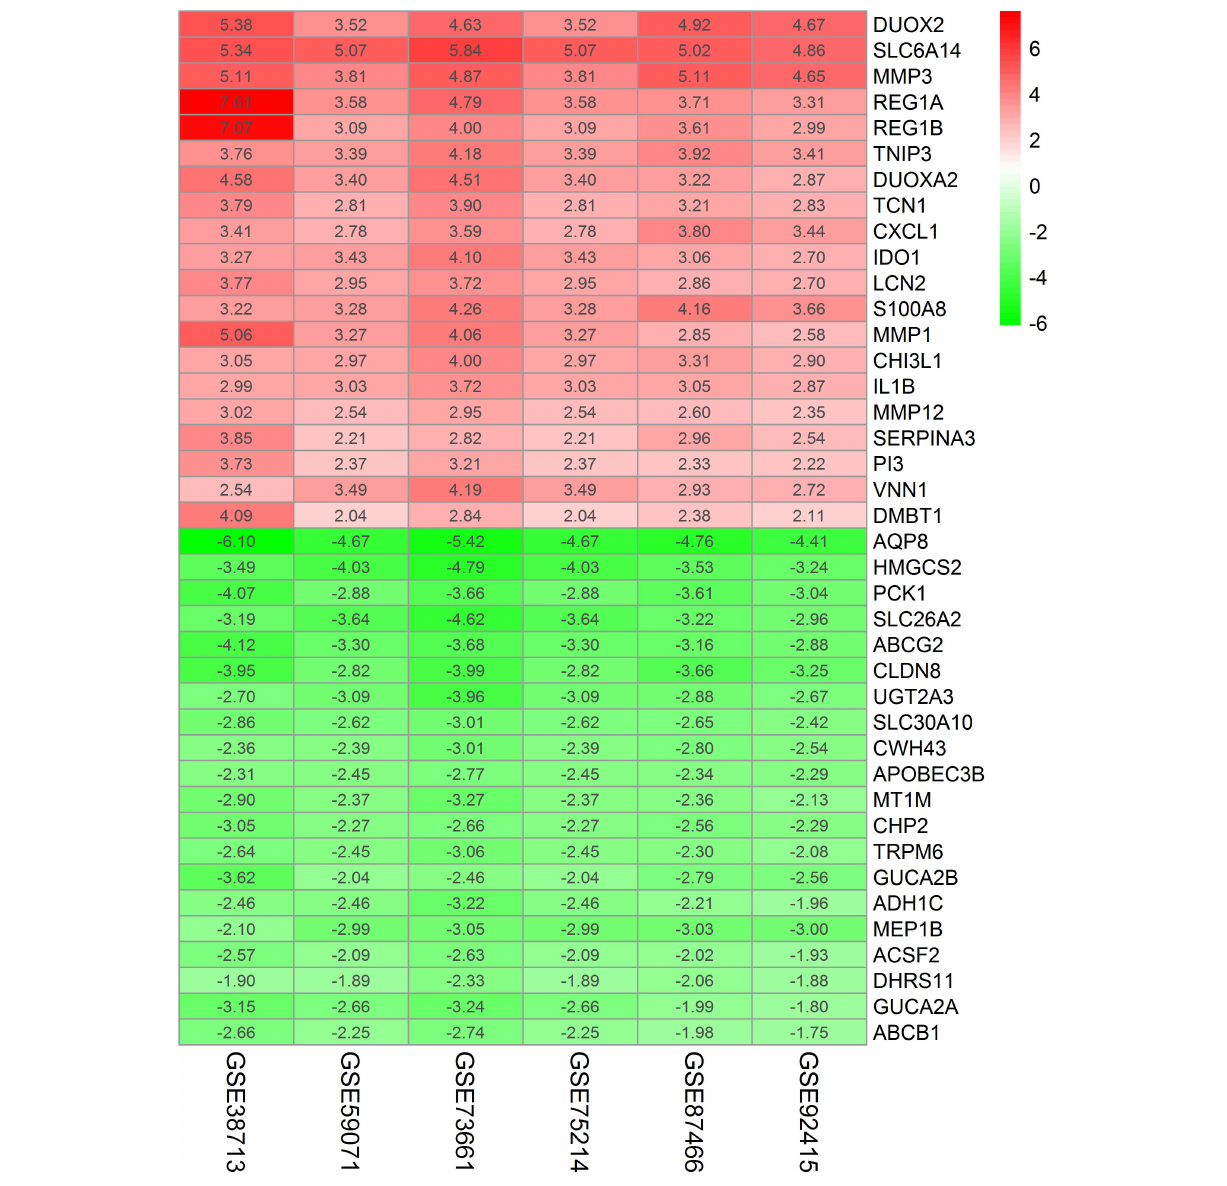
FIGURE 3 | Heatmap of the top 20 DEGs (upregulated or downregulated) identified in the RRA analysis. Red represents a relatively high expression of genes in patients with UC. In contrast, green represents a relatively low expression of genes in patients with UC. The numbers in the heatmap represent logarithmic fold change in each dataset calculated by R